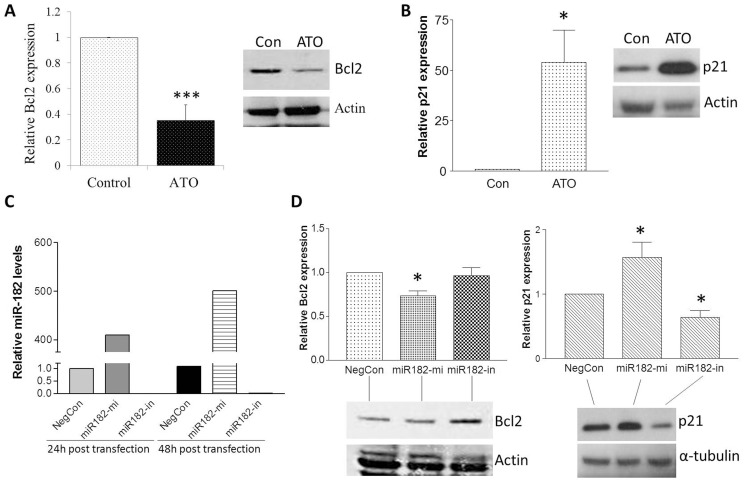
Effect of ATO and alteration of miR-182 on expression of Bcl2 and p21.(A) & (B) PC3 cells were treated with 5 µM ATO for 48 h, followed by qRT-PCR and western blot analysis of Bcl2 (A) and p21(B). Data are expressed as Mean ± SD. n = 3. ATO decreased both mRNA and protein expression of Bcl2 whereas increased both mRNA and protein expression of p21. (C) & (D) PC3 cells were transfected with a negative control (NegCon), miR-182 mimic (miR182-mi), or miR-182 inhibitor (miR182-in) for 24 and/or 48 h, followed by analysis of expression of miR-182 (C), Bcl2 and p21(D). C confirms the successful transfection of miR182-mi and miR182-in by detection of increased or decreased expression of miR-182. D demonstrates Bcl2 and p21 expression status at mRNA (top) and protein levels (bottom) at 48 h post transfection. miR-182 overexpression decreased Bcl2 mRNA expression, but had minimal effect on its protein expression; while miR-182 knock-down had no effect on Bcl2 mRNA expression, but increased its protein expression. p21 was positively correlated to miR-182 expression at both mRNA and protein levels. Actin or α-tubulin served as loading controls for protein expression.